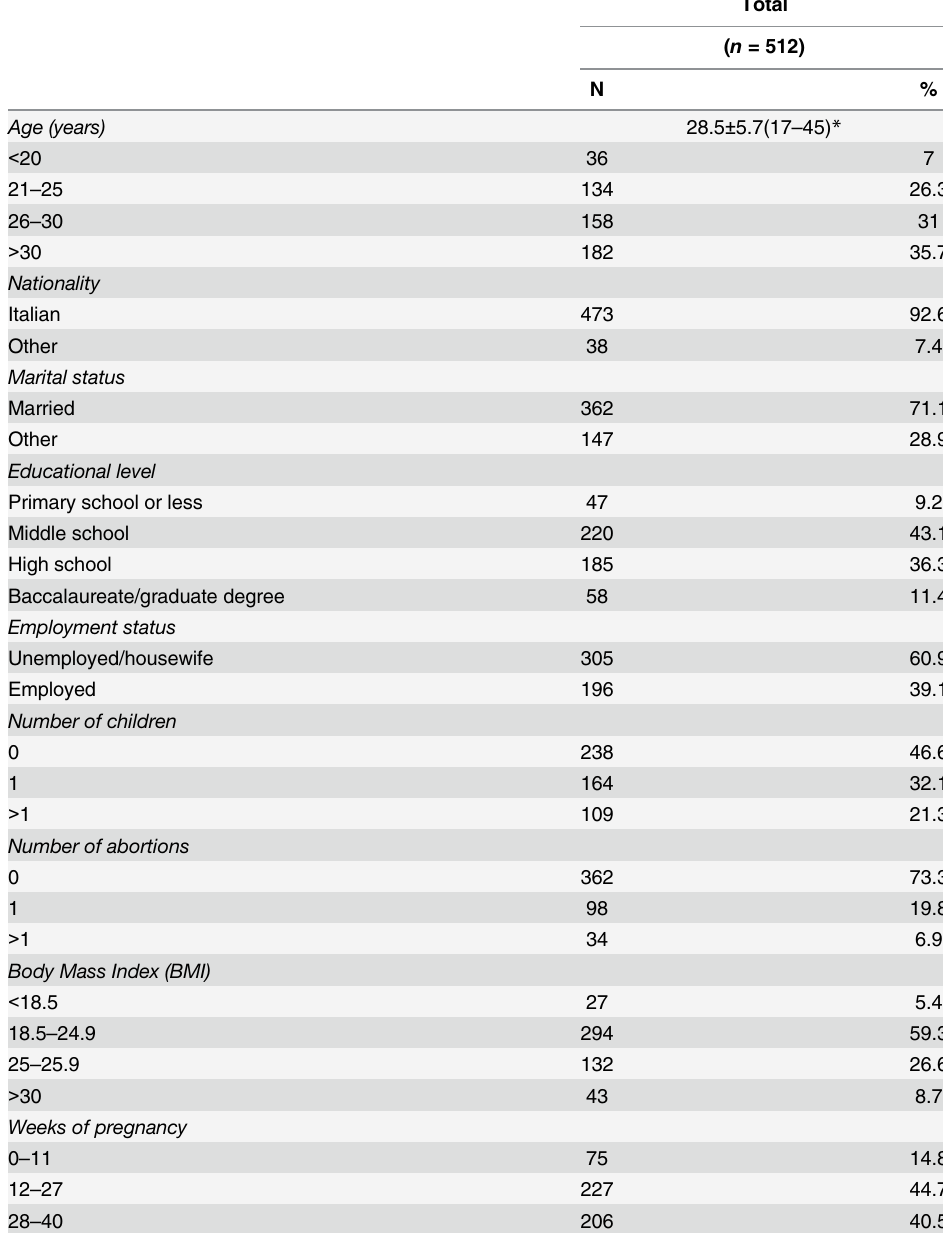
Table 1. Socio-demographic characteristics of the pregnant